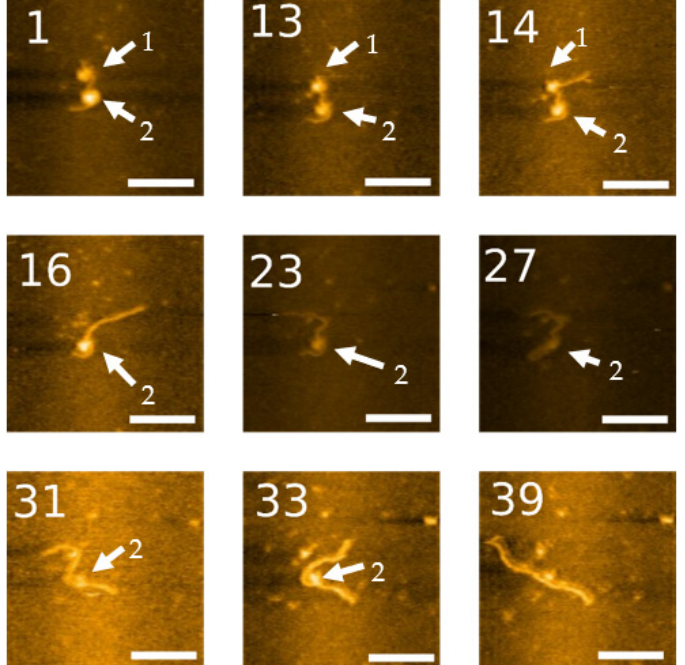
Figure 9. High-speed AFM imaging of dinucleosome dynamics on labeled DNA. The arrow labeled “1” points to a nucleosome assembled near the 3WJ, which can be easily visualized in frame 14. A second nucleosome is marked with an arrow labeled “2”, which remains assembled longer than the other nucleosome. Scale bar indicates 50 nm. The numbers in each image are their frame number in the movie. The complete set of frames can be visualized in Movie S3.